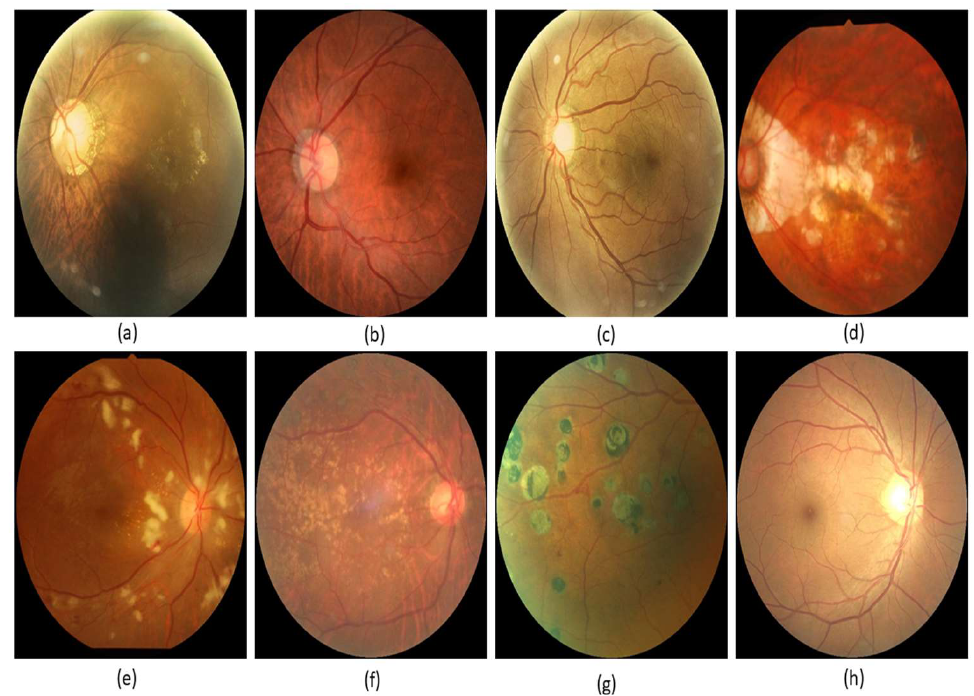
Figure 1. Glaucoma images: ( a ) macular epiretinal membrane, ( b ) normal fundus, ( c ) mild nonproliferative retinopathy, ( d ) pathological myopia, ( e ) hypertensive retinopathy, ( f ) laser spot, moderate nonproliferative retinopathy, ( g ) moderate nonproliferative retinopathy, laser spot, ( h ) mild nonproliferative retinopathy.